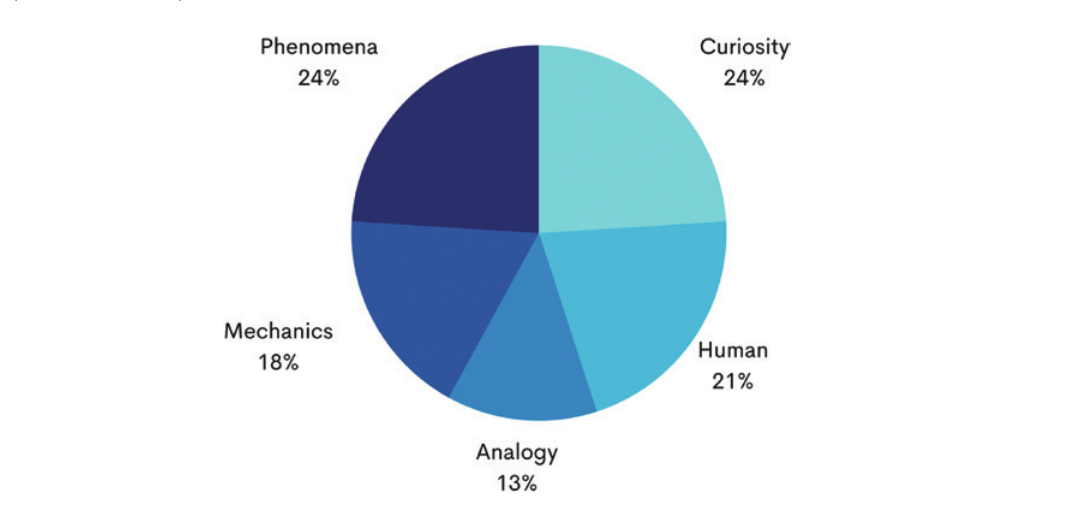
figure 1: summary of percentage of demonstration types used in the show (credit: